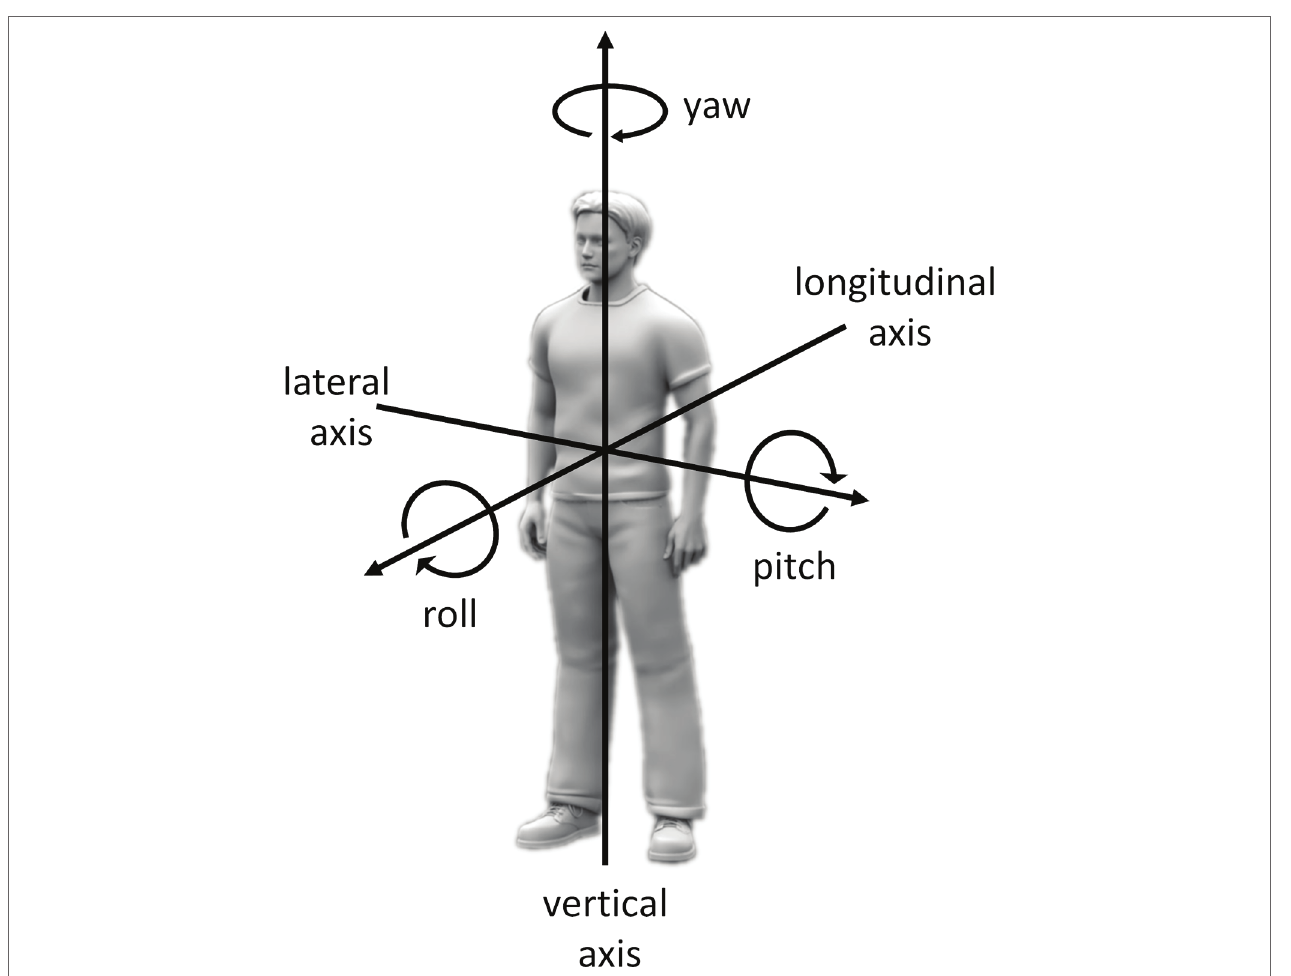
FIGURE 1 | Definitions of the axes of body rotations. For full-body rotations, axes of rotation can be defined relative to a reference frame considering an upright body relative to gravity with the head straight ahead. According to this reference frame, rotations in roll, pitch, and yaw correspond to rotations around the longitudinal (back to front), lateral (left to right), and vertical (foot to head) body axes, respectively. For rotations of specific body parts (e.g., the head), axes of rotation can be defined relative to the same reference frame but with an additional reference to the body part relative to which the moving body part rotates. For instance, turning the head toward the left shoulder when keeping an upright posture relative to gravity can be defined as rotating the head in yaw relative to the